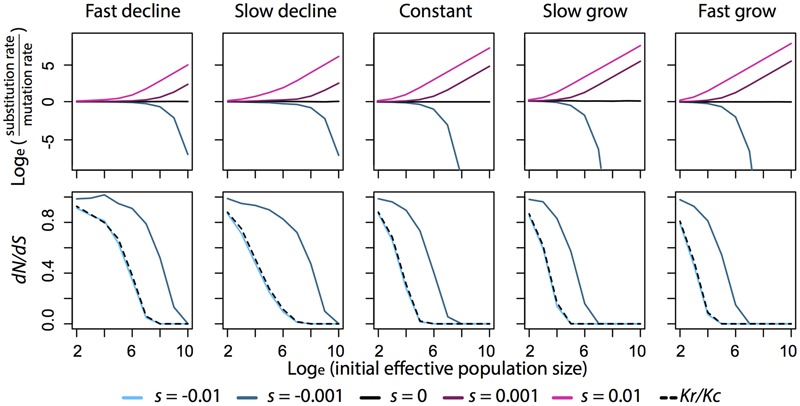
Relationship between substitution rate, dN/dS, Kr/Kc, and effective population size (N𝜀) under different scenarios of population growth and selection coefficient (s). Fixation probability is calculated by the general formula described in the text. To approximate the expectation value in the formula, 500000 replicates of an allele are simulated under a Wright-Fisher model described in Waxman (2011). In each simulation, selection coefficient stays constant and population size changes deterministically over generations. When population grows, the final population size is 1.9 times the initial population size. When population declines, the final population size is 0.1 times the initial population size. Fast population change takes 20 generations to reach the final population size. Slow population change takes 200 generations. Substitution rate is then calculated from the fixation probability and is plotted on natural log scale with respect to mutation rate, so when substitution rate equals mutation rate, the value is 0 in the plots. dN/dS is calculated as the ratio between the fixation probability of a slightly deleterious mutation (s = -0.001) to that of a neutral mutation (s = 0). Kr/Kc is calculated as the ratio between the fixation probability of a deleterious mutation (s = -0.01) to that of a slightly deleterious mutation (s = -0.001).